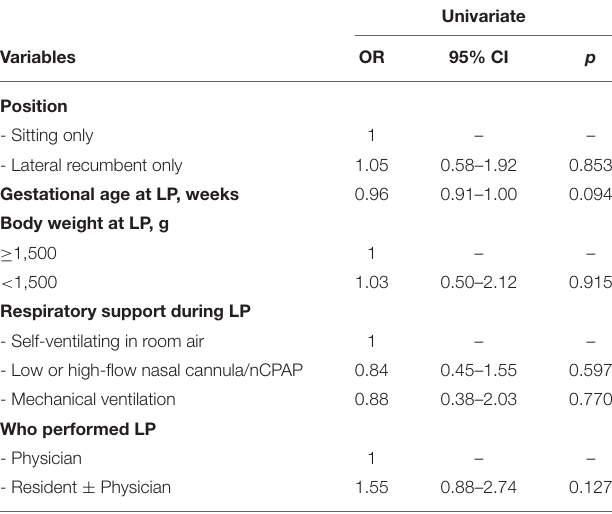
TABLE 4 | Univariate analysis of factors associated with lumbar puncture